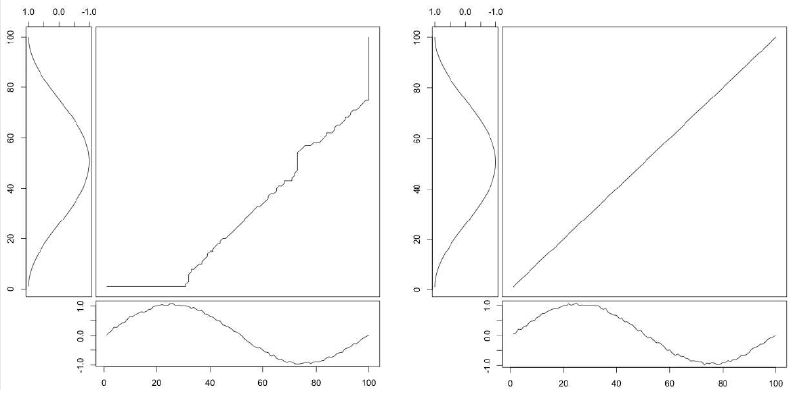
Figure A1. Optimal alignment path between two sample time series with time warping (left), without time warping (right).